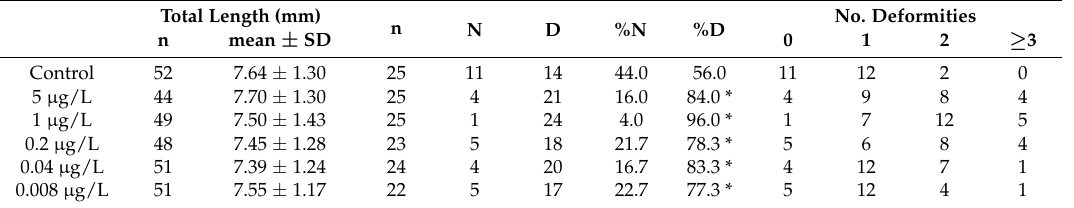
Table 1. Total length, number of deformed fish per conditions and of deformities per deformed fish upon exposure of zebrafish larvae to cadmium. n, number of fish observed; N, number of fish without deformities; D, number of fish with one or more deformities; %N, percentage of non-deformed fish; %D, percentage of deformed fish; * indicates values statistically different from the control (chi-squared test, 1 degree of freedom, p < 0.05).